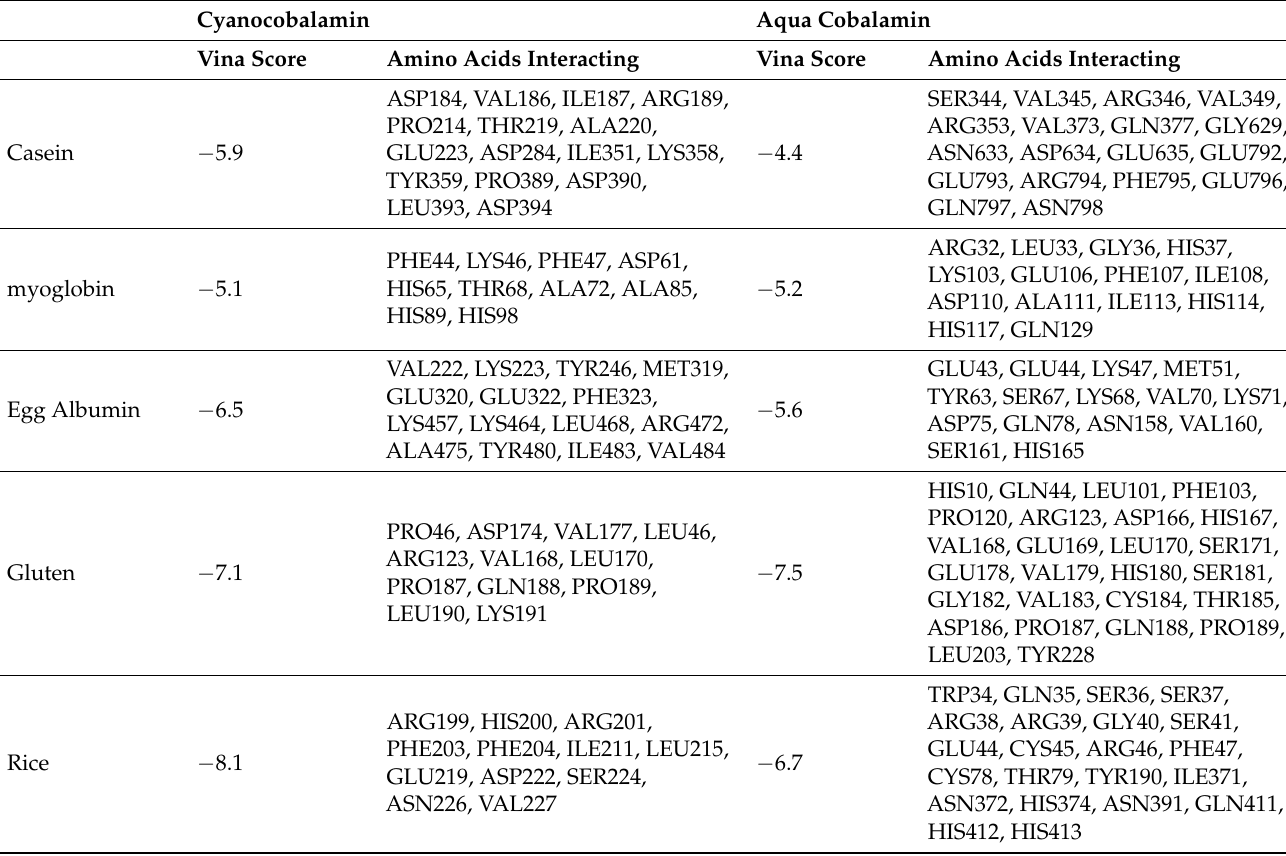
Table 3. Vina Score and amino acids associated with vitamin B12—protein